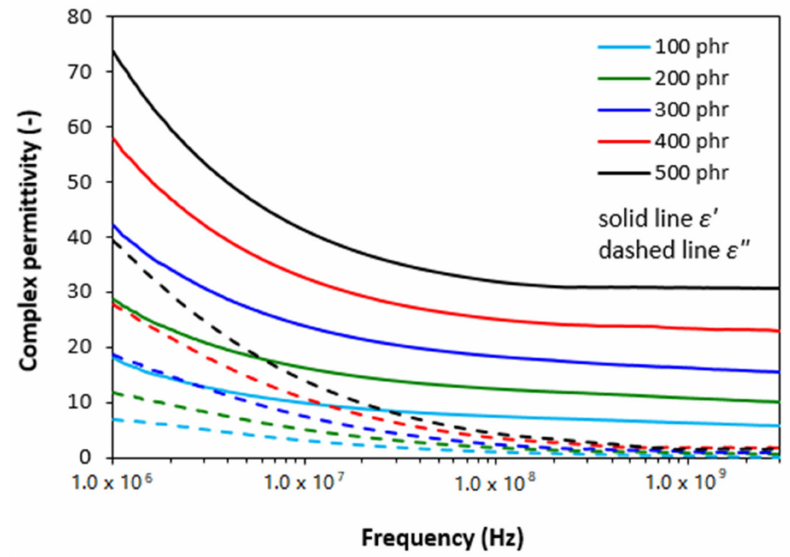
Figure 2. Frequency dependences of real ε (cid:48) and imaginary ε (cid:48)(cid:48) parts of complex permittivity for ferrite filled composites.